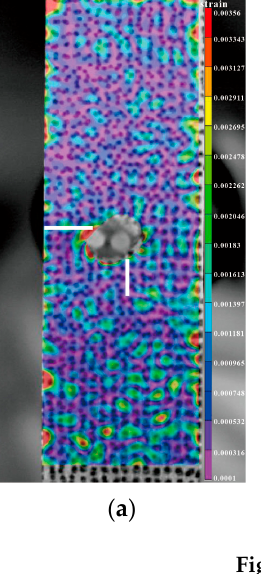
Figure 23. Von Mises strain of the single-hole test piece (entry plane): ( a ) von Mises strain of the left and lower sides of the hole by FEM; ( b ) von Mises strain of the left and lower sides of the hole by DIC.